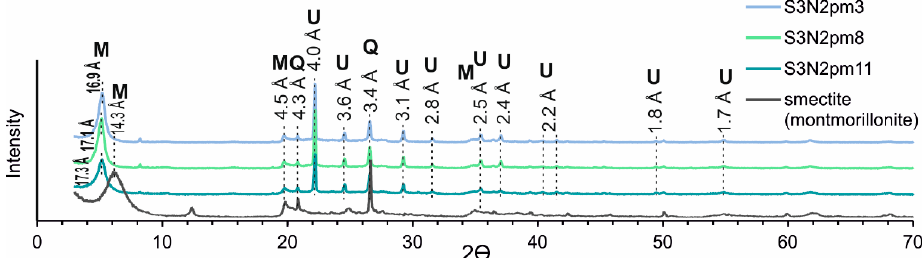
Figure 1. XRD patterns of the composites for different grinding times. Note the shift of smectite (M), urea (U) and quartz (Q) peaks in the composites.